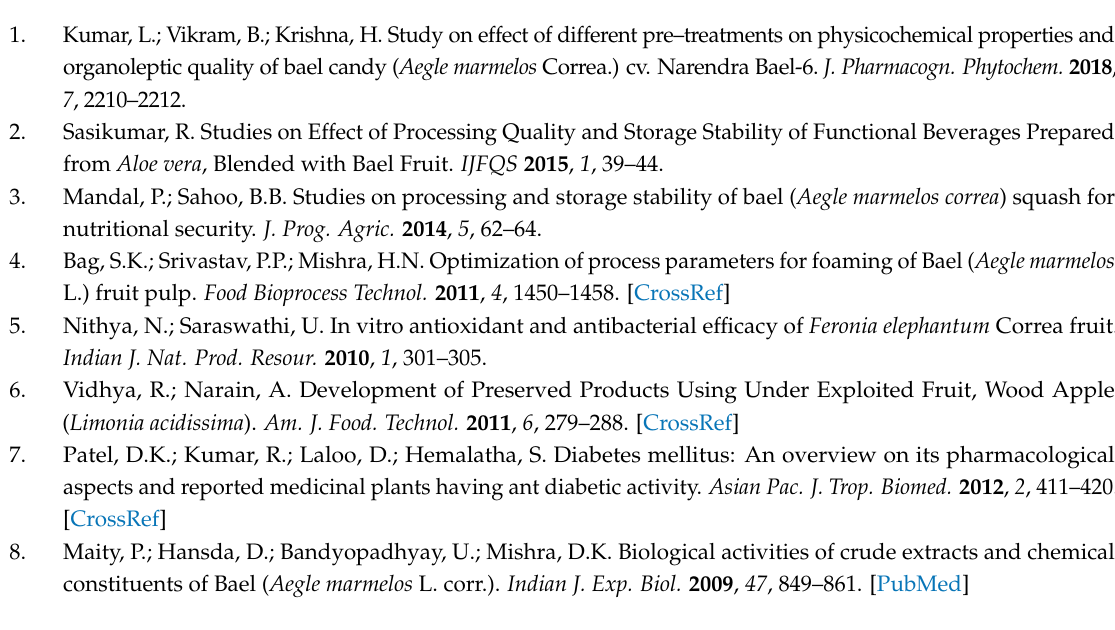
Values represent the mean ± standard deviation of 3 replicates ( n = 3); abcdef column—means within the different superscript letter were significantly different ( p < 0.05); ABCDEF row—means within the different superscript letter were significantly different ( p <